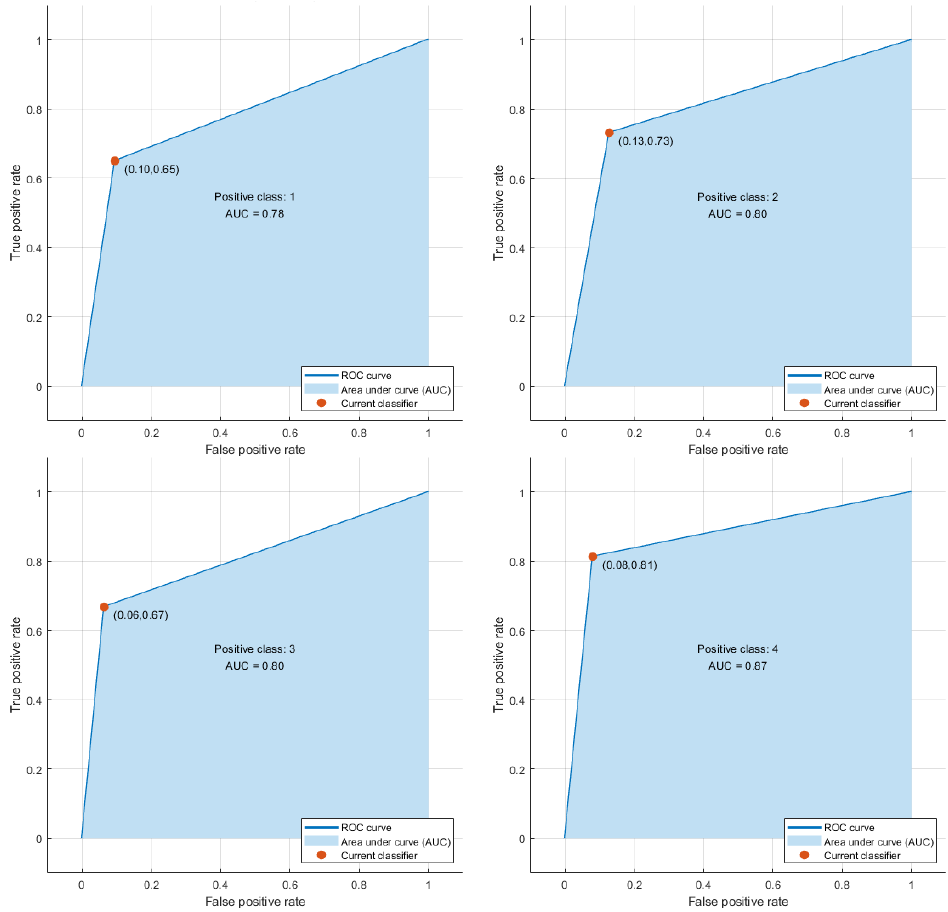
Figure A4. ROC curves of